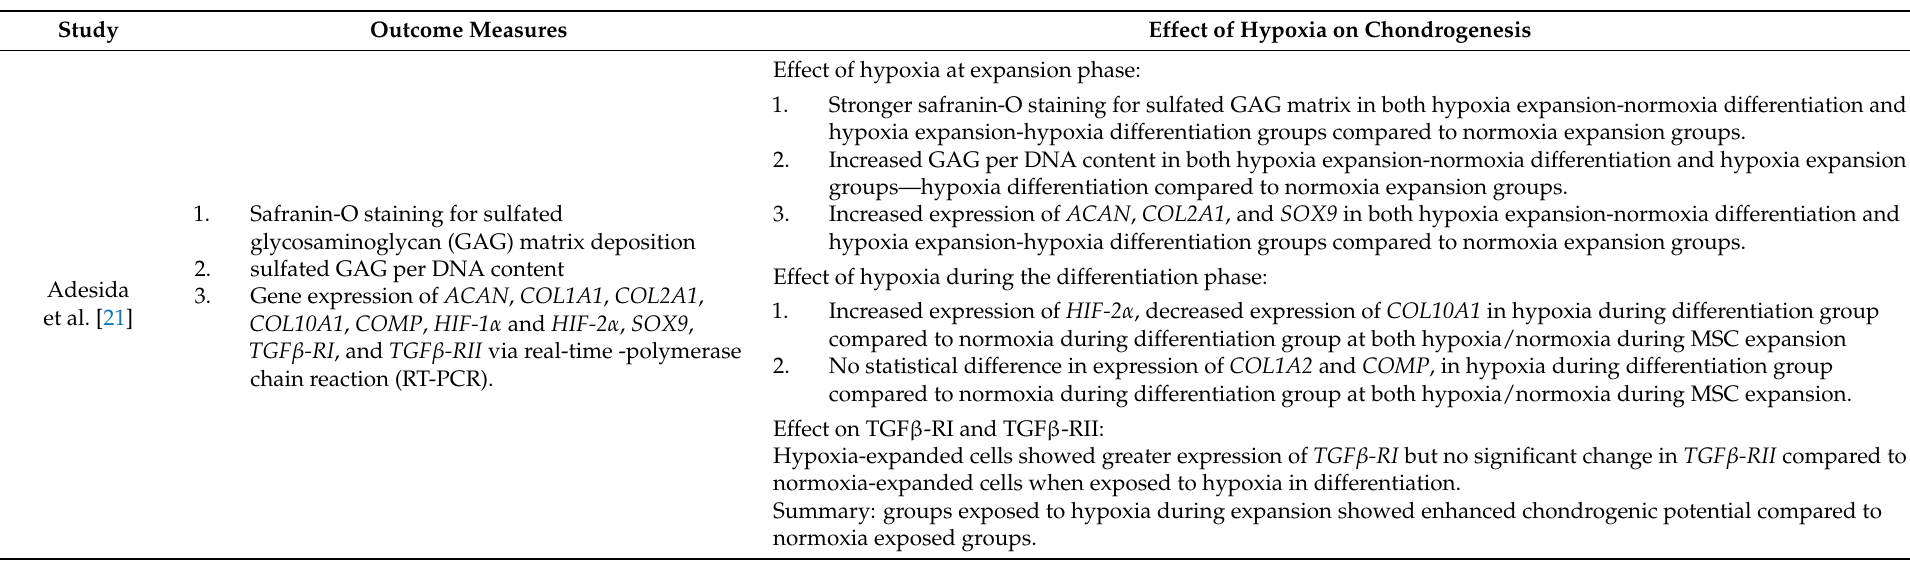
Table 2. Study results. Shows the following information for each study included in this review- outcome measures used in each study and the results of the effect of hypoxia on